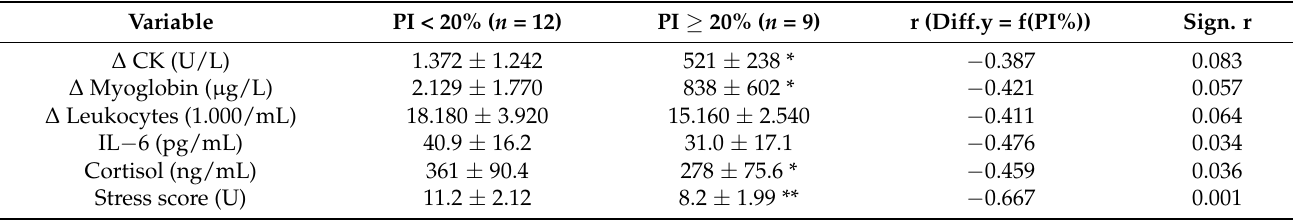
Table 4. Differences in exercise-induced stress markers and the calculated stress score among the athletes who completed the marathon race ( n = 21) differentiated by their